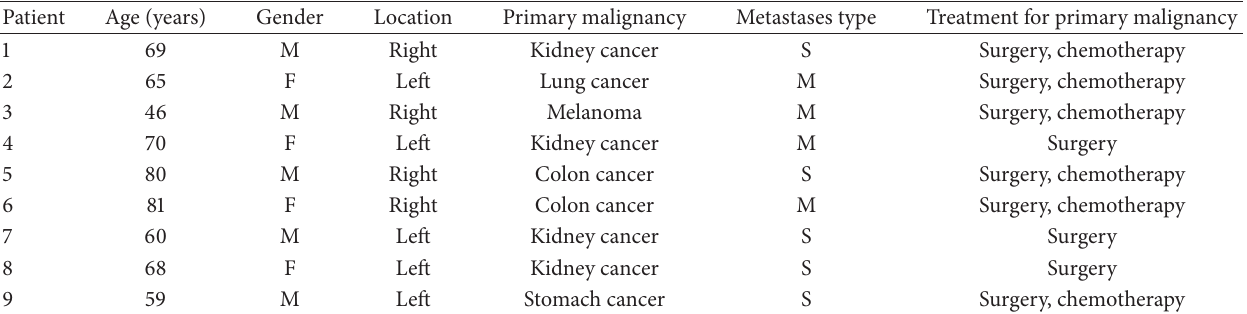
Table 1: Patient characteristics and perioperative data.